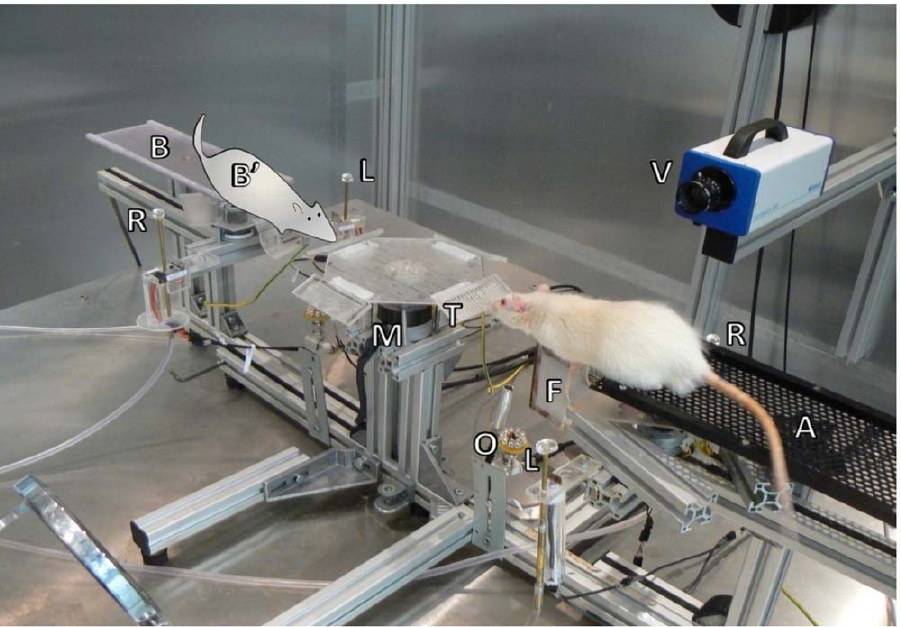
Figure 1. Experimental setup. Photograph of texture palpation taken under visible light. A-platform A, B-platform B, B’-rat position on platform B, M-motor for automated presentation of textures, T-textured plate, F-foot rest, O-optical triggers for touch detection, L, R-left and right water spouts, V-high-speed video camera. While the rat collected the reward, the motor rotated to put one of the four textures, in random order, in position for the next trial. The motorized foot rest (F) was then extended to allow the rat to reach the texture. When the rat withdrew after texture palpation, the foot rest was retracted to prevent the animal from returning to the texture. Optical triggers were positioned in front of the texture to detect touch and the beginning of turn (i.e. the moment when the animal retracted from the texture). The animal’s choice was detected by another set of optical triggers (not labeled) located immediately adjacent to the drinking wells.